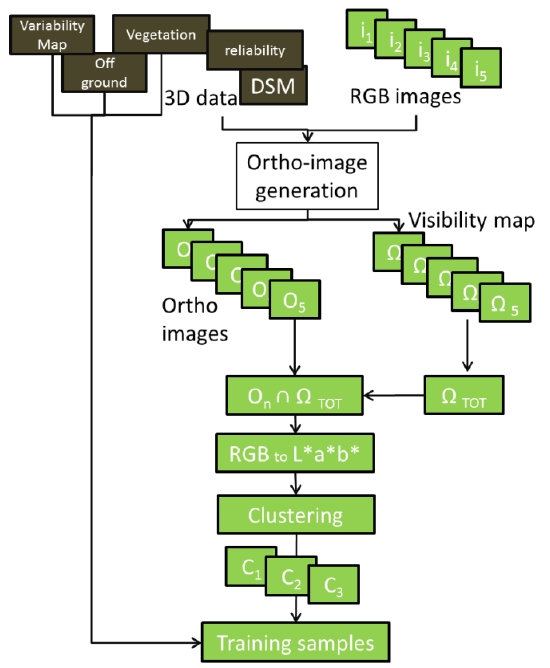
Figure 3: Scheme of the training